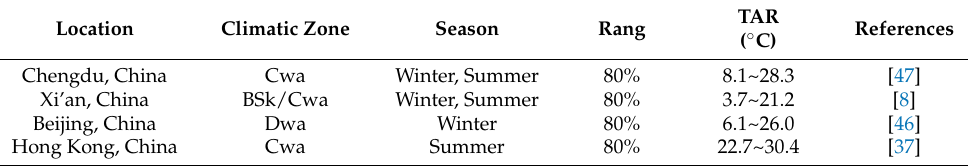
Table 9. TAR in other outdoor thermal comfort